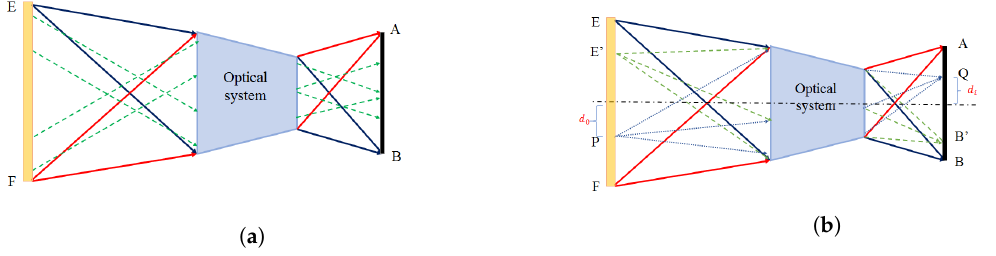
Figure 1. Difference between imaging and non-imaging optical devices. ( a ) Non-imaging optics; ( b ) imaging optics.